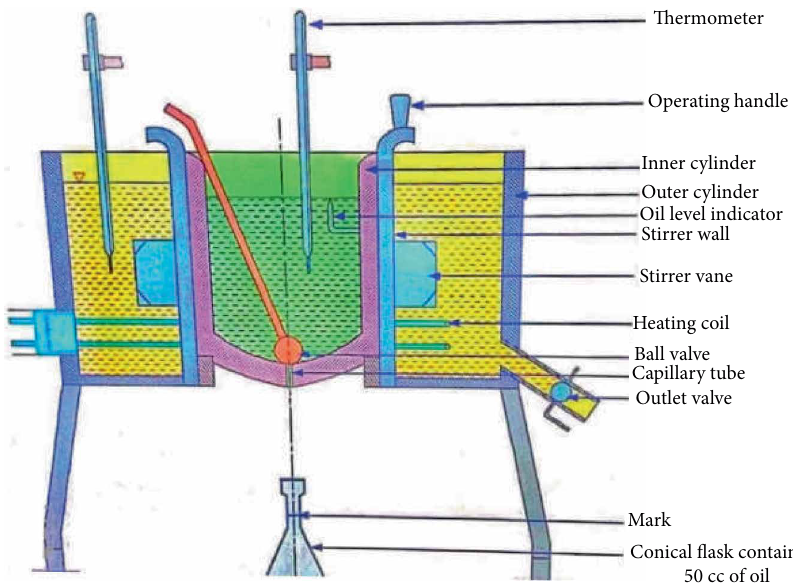
Figure 3: Sectional front view of the Redwood viscometer.